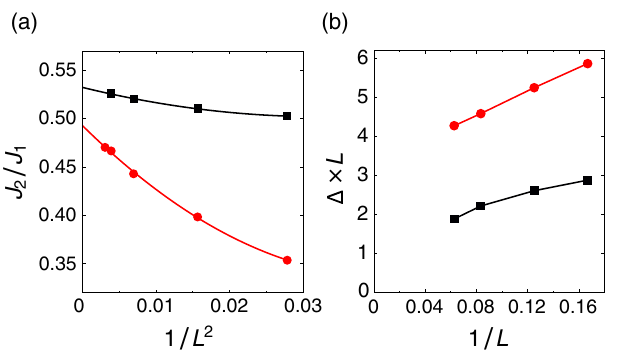
FIG. 4. (a) System-size dependence of singlet-quintuplet (red dots) and singlet-triplet (black squares) level crossings indicated by red and black arrows in Fig. 3. The extrapolation to the thermodynamic limit is done by the polynomial fit a þ b=L 2 þ c=L 4 (solid curves). (b) System-size dependence of the excitation gap Δ at the two level crossings. For the singlet-quintuplet level crossing in (a), the 18 × 18 data are added to corroborate the result.